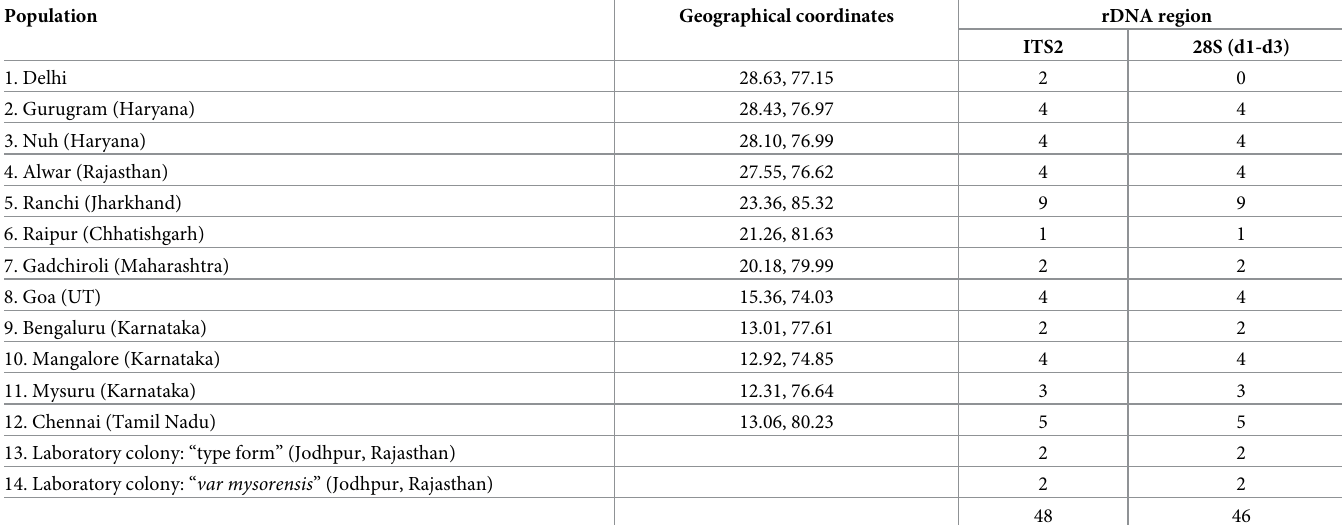
Table 1. Number of samples subjected to direct sequencing of rDNA